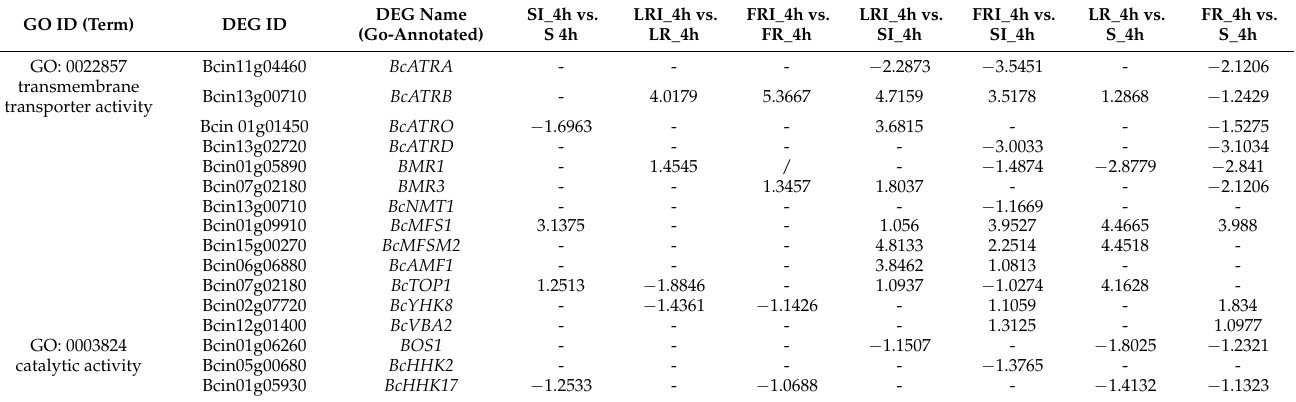
Table 4. Summary of GO enriched DEGs associated with fludioxonil